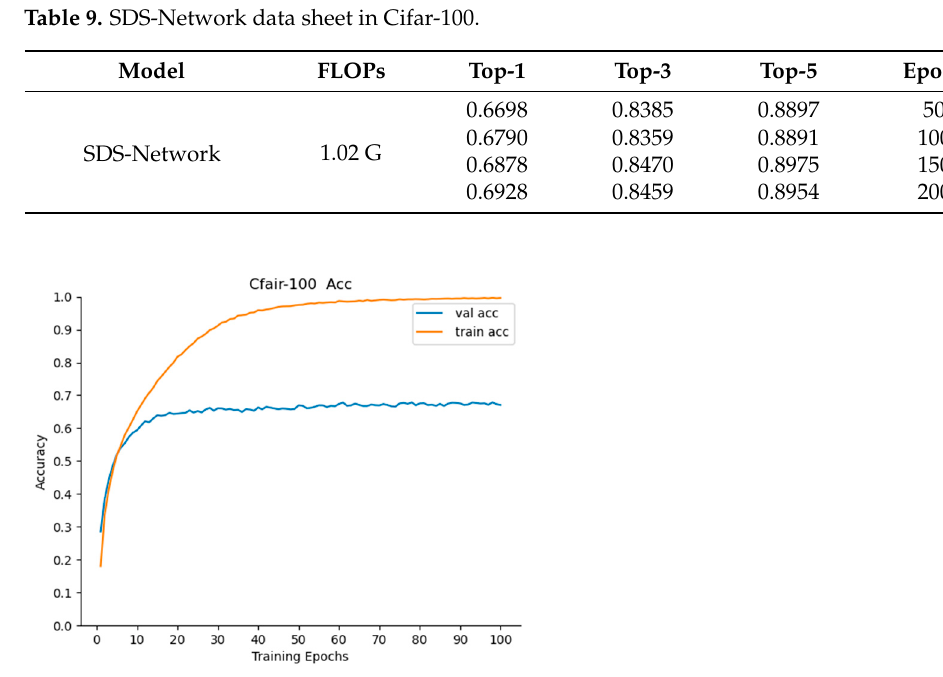
Table 10. SDS-Network data sheet in Caltech.